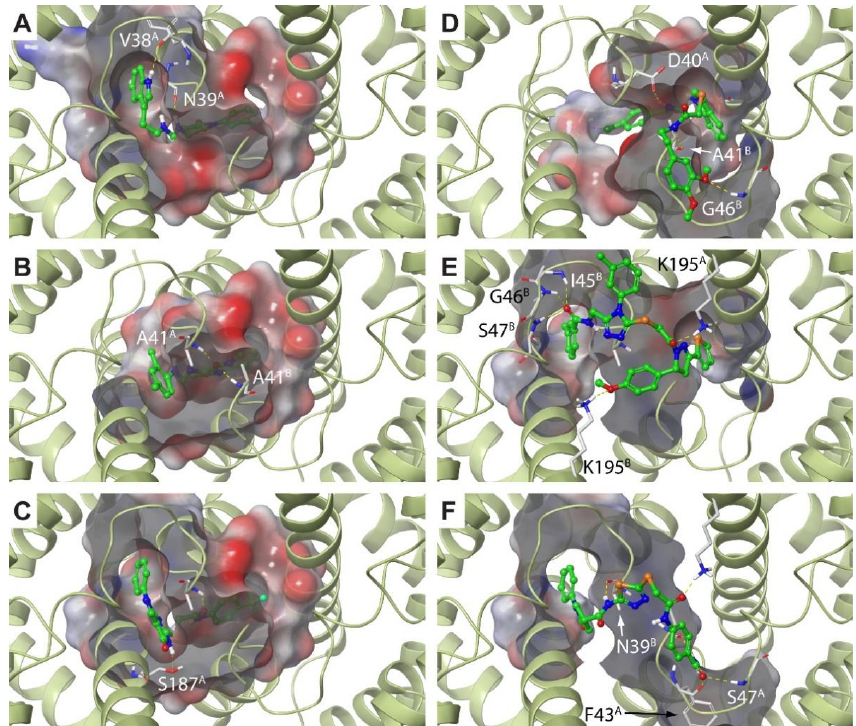
Figure 5. Docking poses for Compounds B1–3 (Panels A – C ) and E1–3 ( D – F ) in the F#1 site. Hp (UreF) 2 ribbons are in dark green, and residues involved in the binding are labeled and depicted as thin sticks colored according to atom type. Considering that the F#1 binding site is at the dimerization interface, the chain identifier has been added to the residue labels. The B1–3 and E1–3 compounds are shown as green sticks, where heteroatoms have been colored according to atom type. Hydrogen bonds are shown using yellow dashed